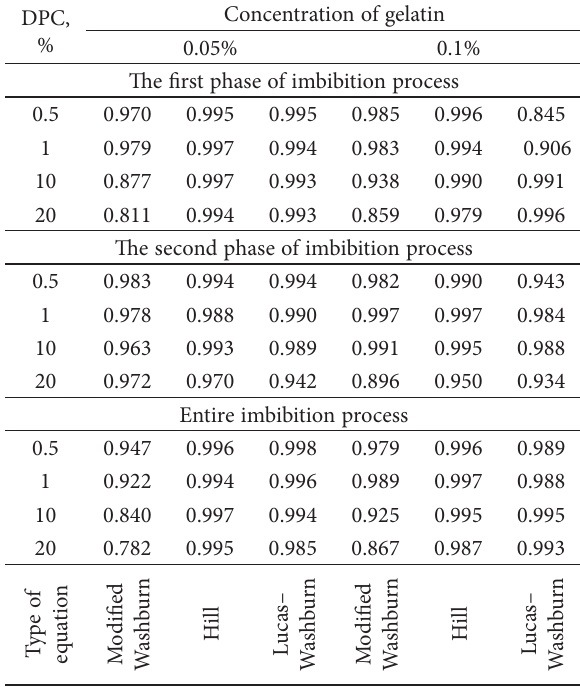
Table 5. The correlation coefficient values for applied equations